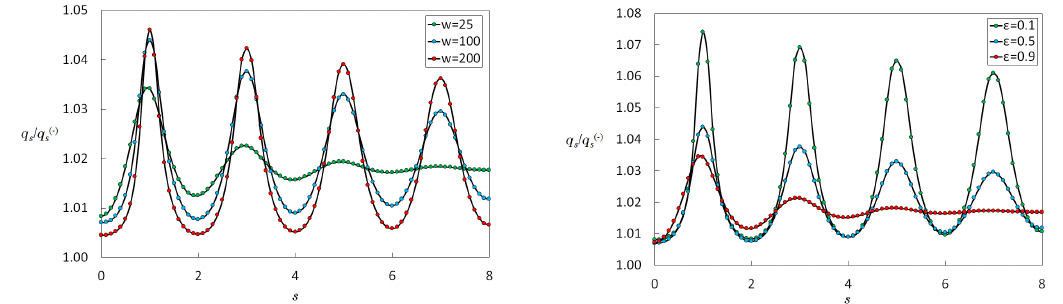
( − ) s on s . ( Left ) w changes, ε